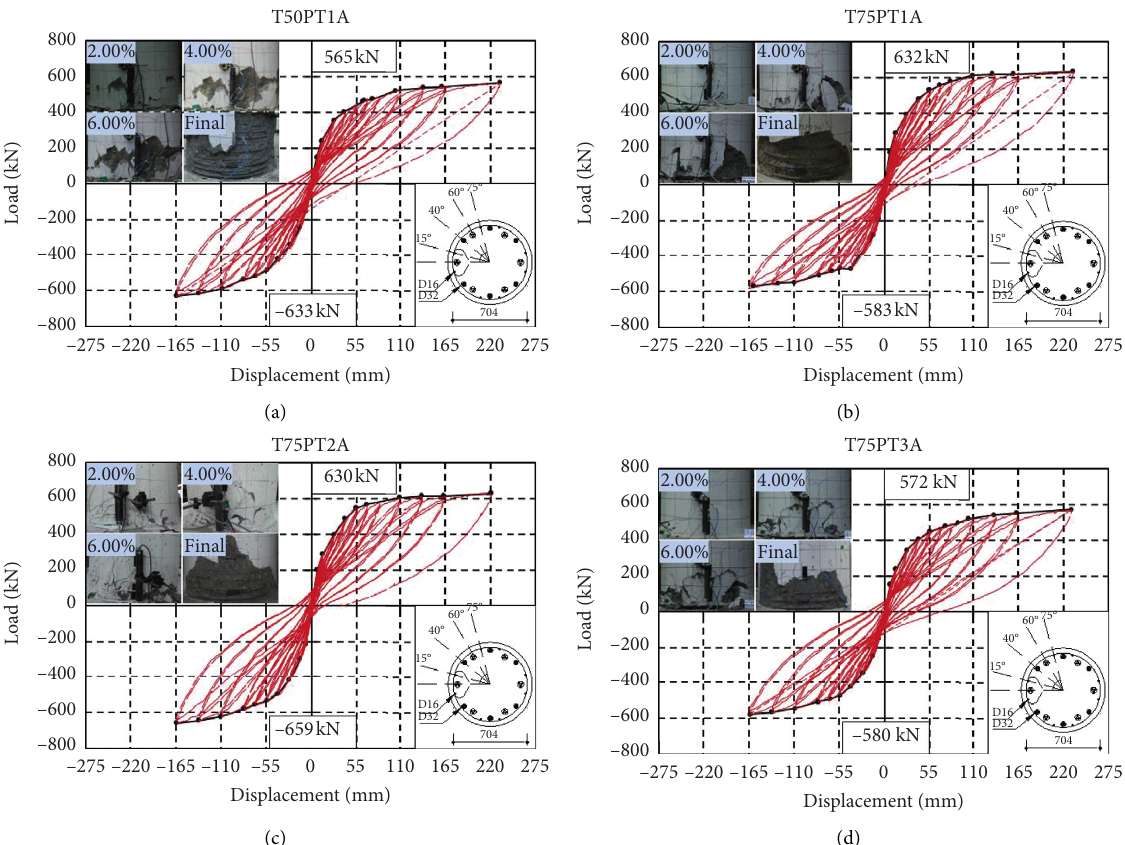
Figure 5: Load-displacement curves. (a) T50PT1A. (b) T75PT1A. (c) T75PT2A. (d)